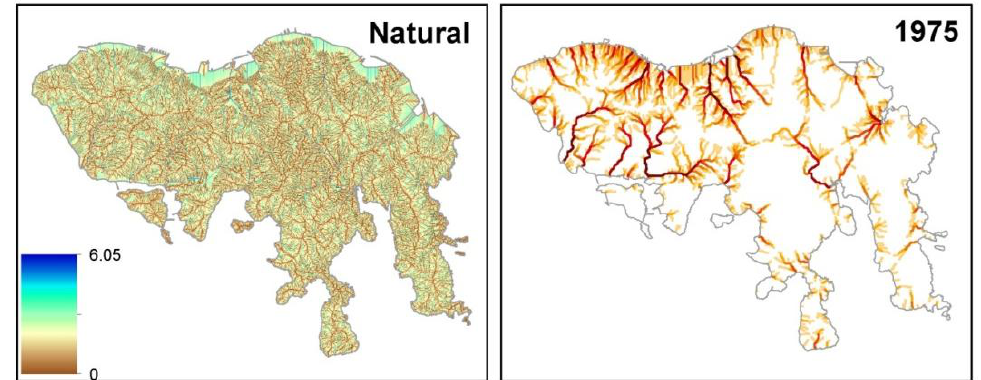
Figure 10. Runoff analysis—natural runoff assuming no buildings (upper left panel; values log transformed). Temporal changes in runoff from buildings, assuming no urban drainage systems, for the years 1930, 1952, 1975, 1993/5, and 2003/6. The values indicate the accumulated number of pixels contributing runoff to each pixel, based on the digital elevation model, and on the distribution of built-up